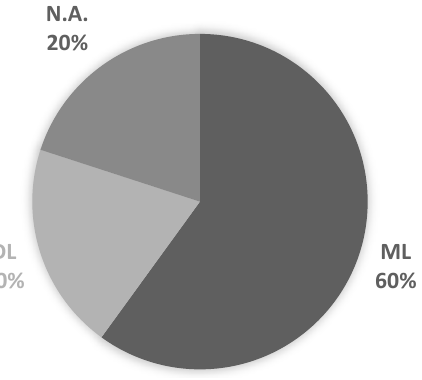
Figure 7. Use of machine learning (ML) and deep learning (DL) techniques in the selected studies. N.A. corresponds to works that did not employ artificial intelligence techniques.